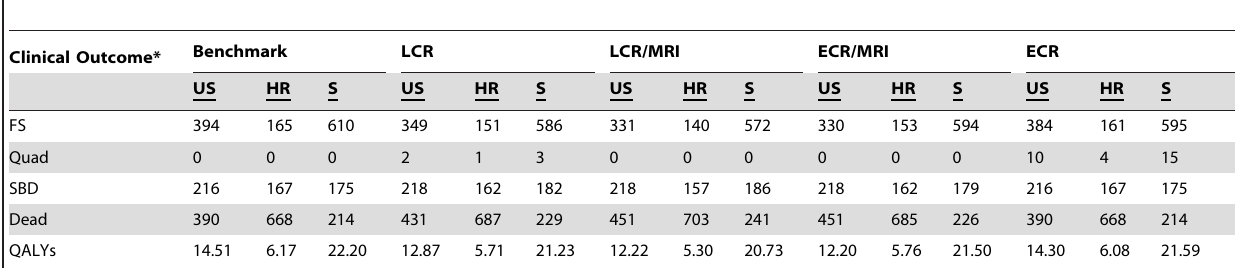
Table 3. Expected Clinical Outcomes per 1,000 and QALYs By CSM Strategy and Patient Category with 2.5% Probability of Cervical Spine